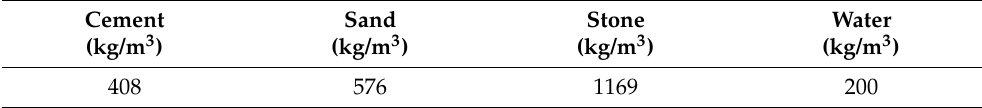
Table 1. Mix proportions of the concrete. Figure 1. Wave-absorbing concrete samples: ( a ) unit cell of the metamaterial absorber sample; ( b ) optical image of EMW absorbing concrete sample.